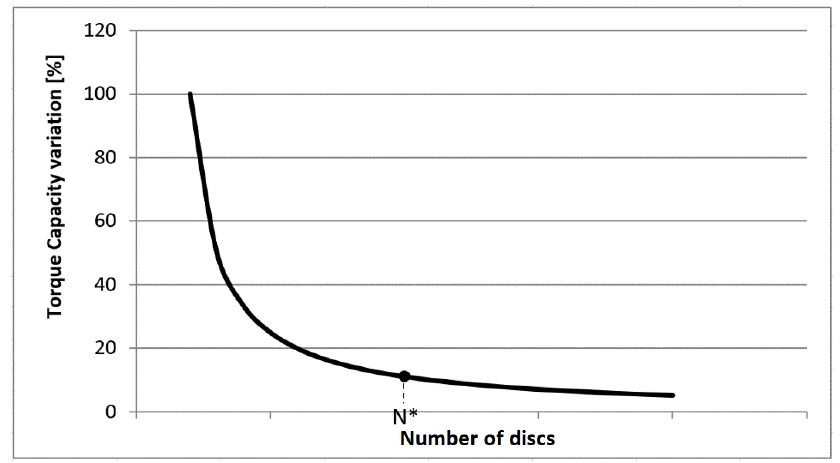
Figure 5. Variation of the torque capacity by increasing the number of friction discs.